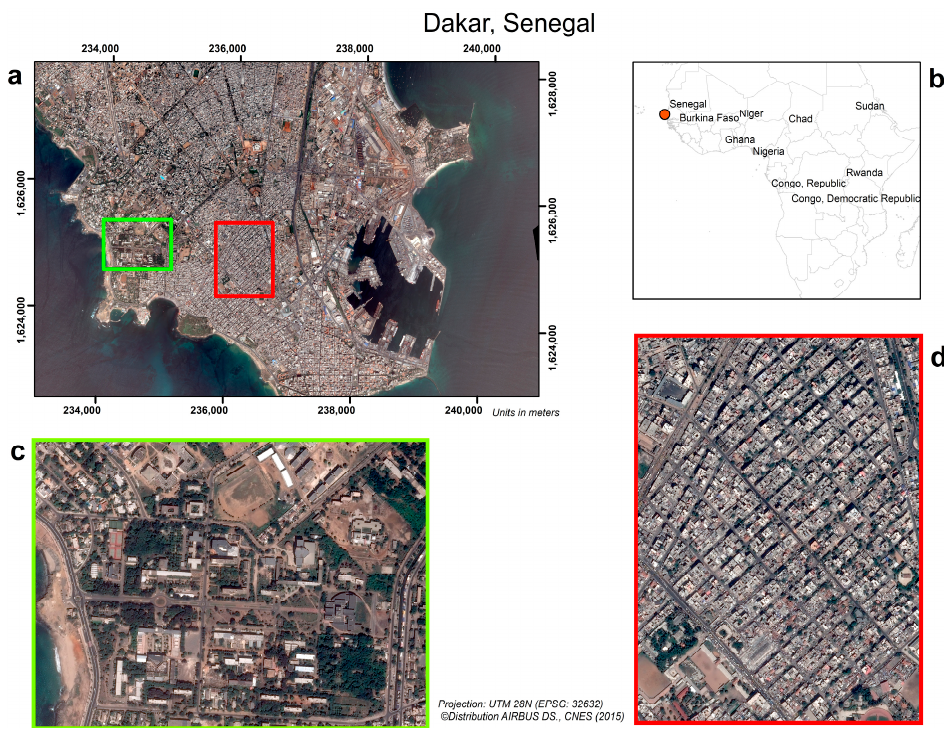
Figure 1. ( a ) Pleiades image of Dakar (RGB composite), ( b ) location map of Dakar within the African continent, ( c ) ROI 1 (1.05 km 2 ), representing a low-density large size built-up zone and ( d ) ROI 2 (0.82 km 2 ), representing a high-density medium sized built-up zone.